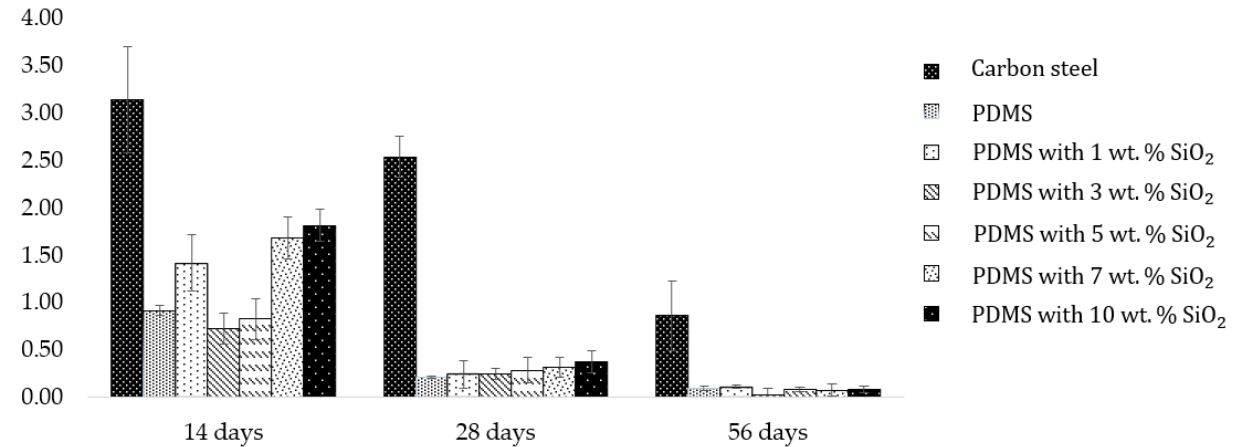
Figure 6. Barnacle adhesion strength (MPa) on surfaces of different materials after 28 days and 56 days in seawater (facing away from the shore). 3.1.4. Mechanical Properties Studies of PDMS/SiO 2 Composite Another important property for the application of an antifouling coating film are me- chanical properties, such as tensile strength. The strength of the neat PDMS and PDMS/SiO 2 composite films, and mechanical properties of both neat PDMS and PDMS/SiO 2 composites were studied. The results obtained from the tensile tests for the neat PDMS and PDMS/SiO 2 composites with various weight percentages of SiO 2 are pre- sented in Figure 7, which is a plot between stress and strain of the different composite films. The neat PDMS film showed an elastic property with a Young’s modulus of 1.50 ± 0.18 MPa. Young’s modulus of the composite with the addition wt.% of SiO 2 in the PDMS matrix phase at 3, 5, 7 and 10 wt.% was 2.92 ± 0.96 MPa, 3.07 ± 0.59 MPa, 2.68 ± 1.91 MPa and 2.30 ± 0.39 MPa, respectively. It is interesting to note that further increasing of the SiO 2 content from 7 wt.% caused SiO 2 particles to agglomerate (as observed from SEM